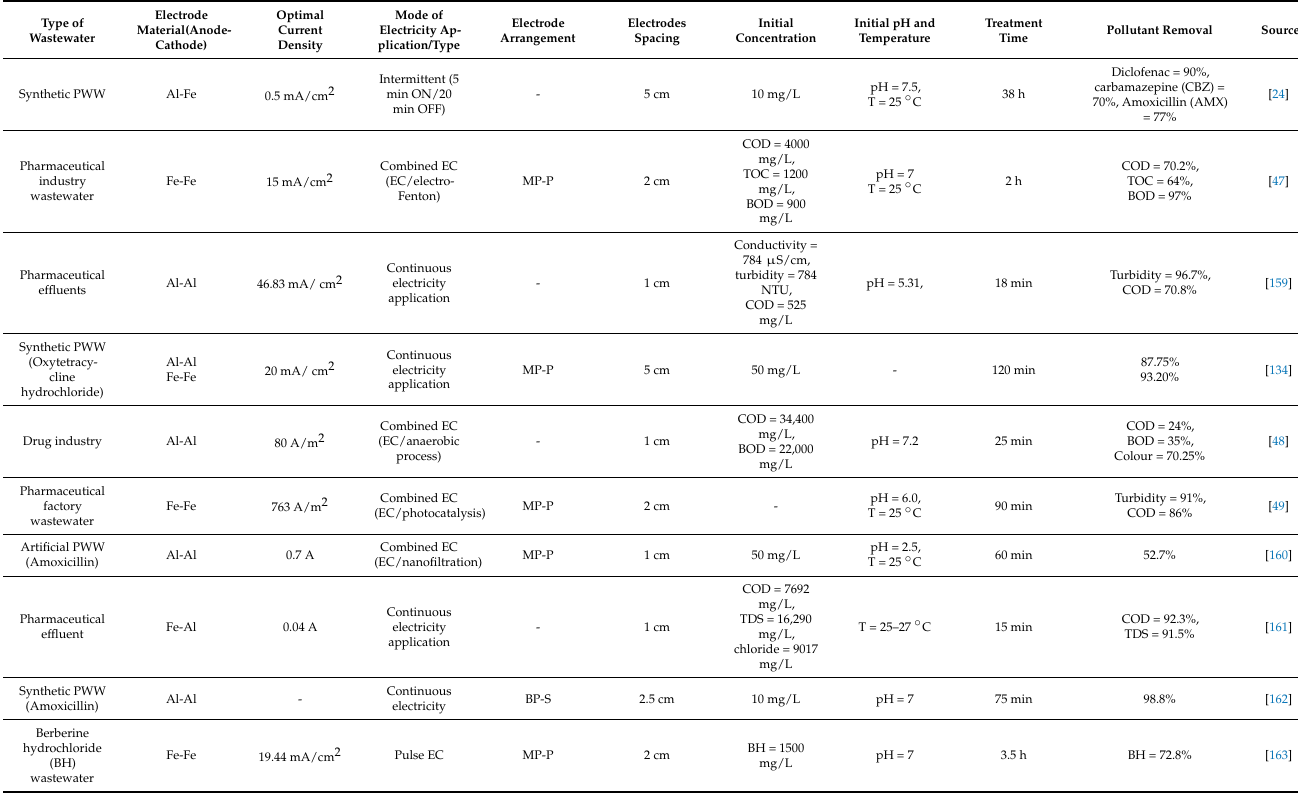
Table 5. Summary of EC applied for wide range of PWW with pollutant removal efficiency at optimum